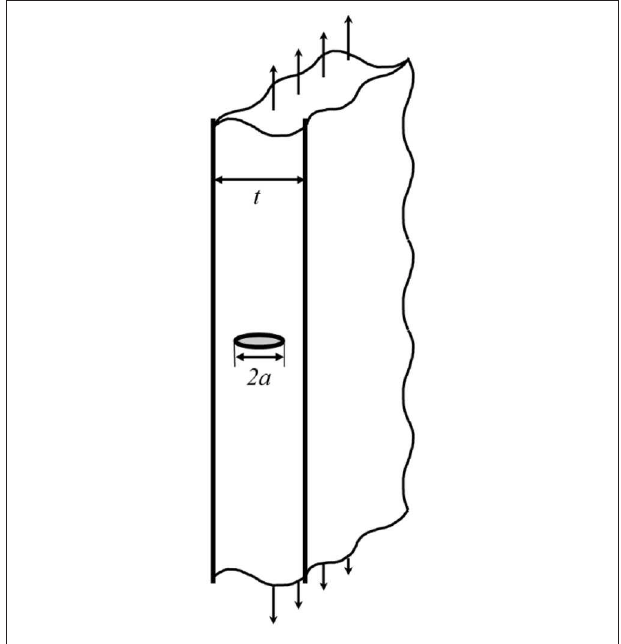
FIGURE 1 | Schematic illustration of a cracked plate under uniaxial tensile